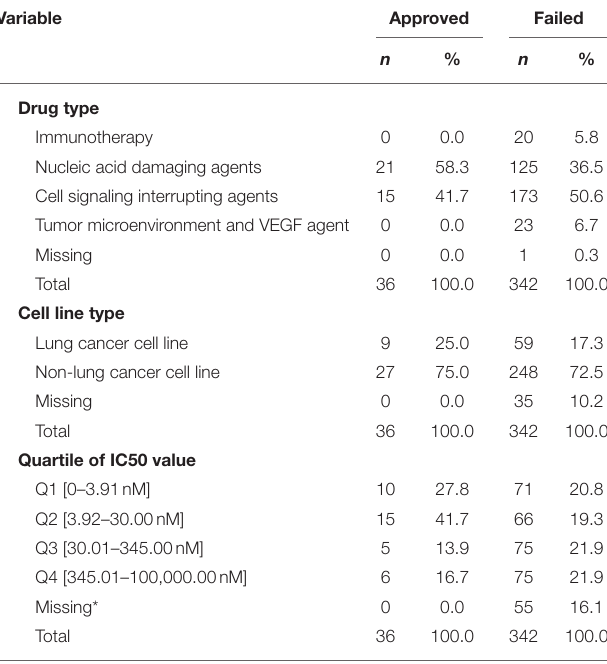
TABLE 1 | Descriptive distributions on initial